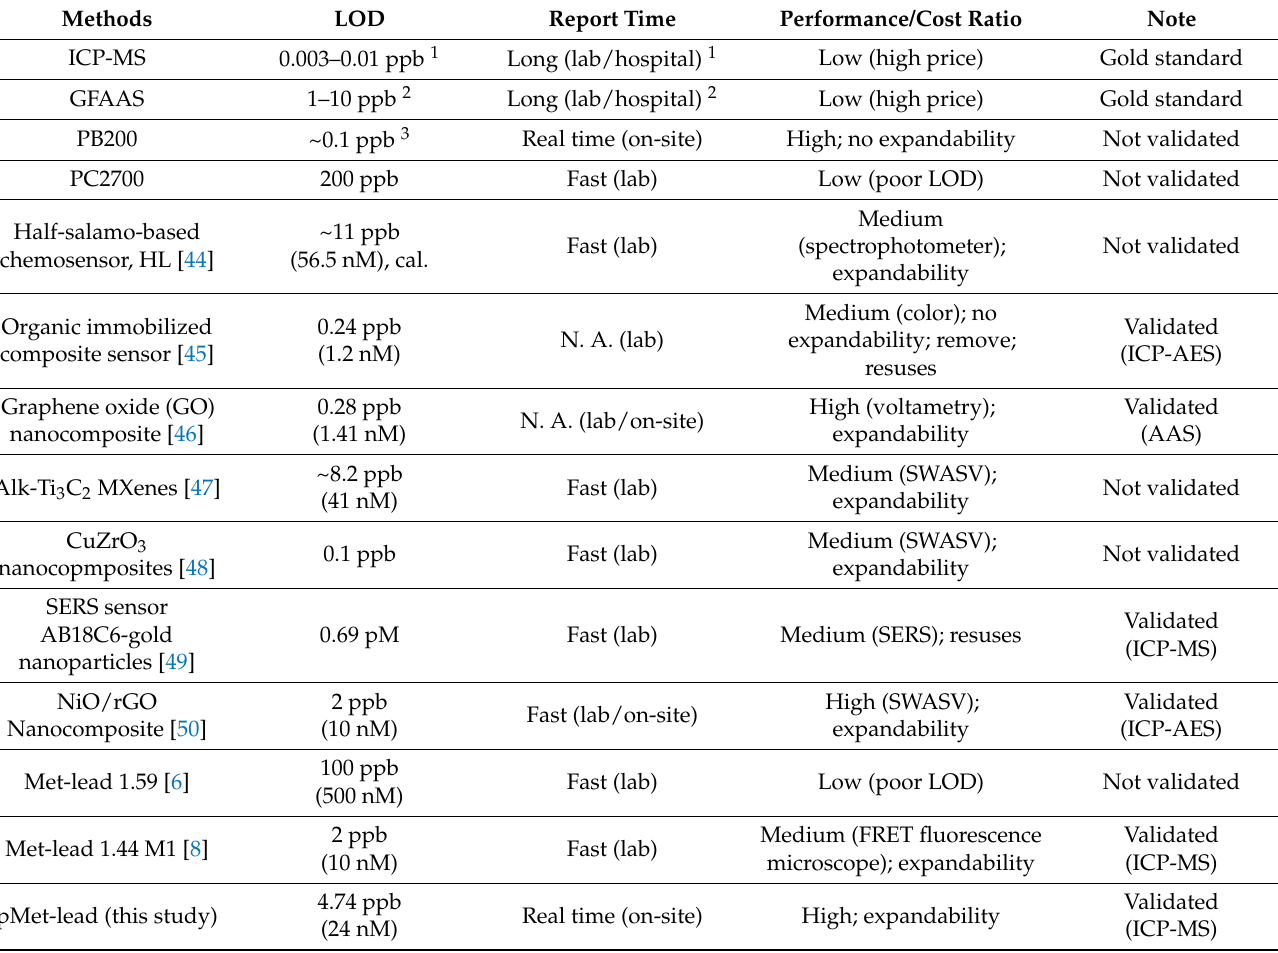
Table 3. Pb detection in different water supply systems. pMet-lead FRET ratios of practical Pb measurements from various sources of water in this study (Figure 6) were validated using the general standard method